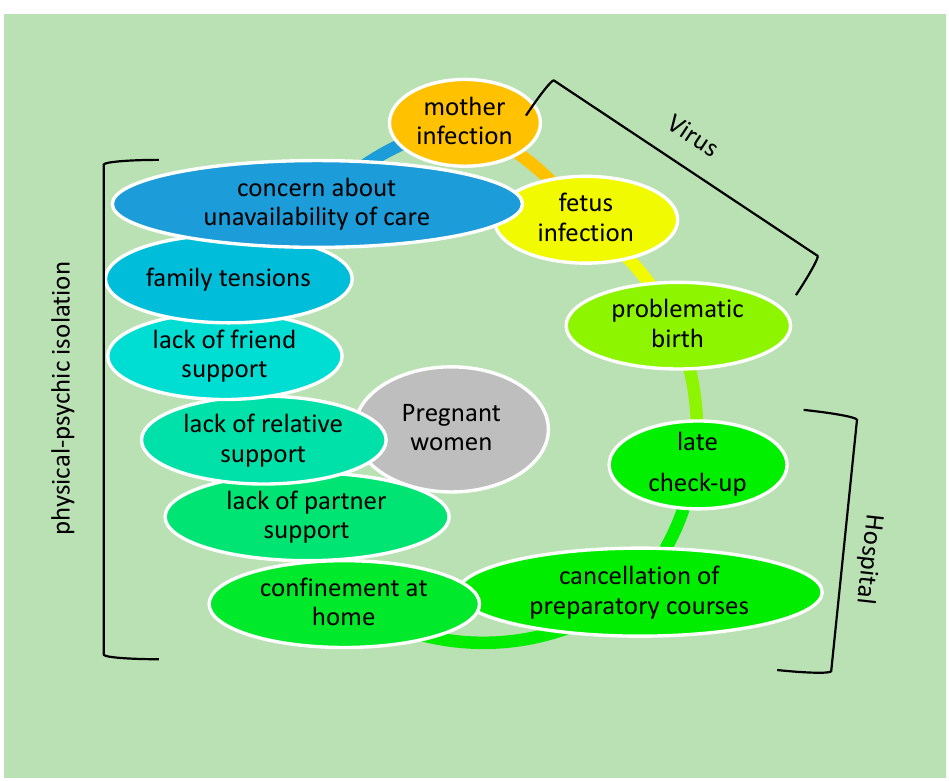
Figure 1. Schematic representation of the main causes affecting the mental health of pregnant women during the COVID-19 pandemic.